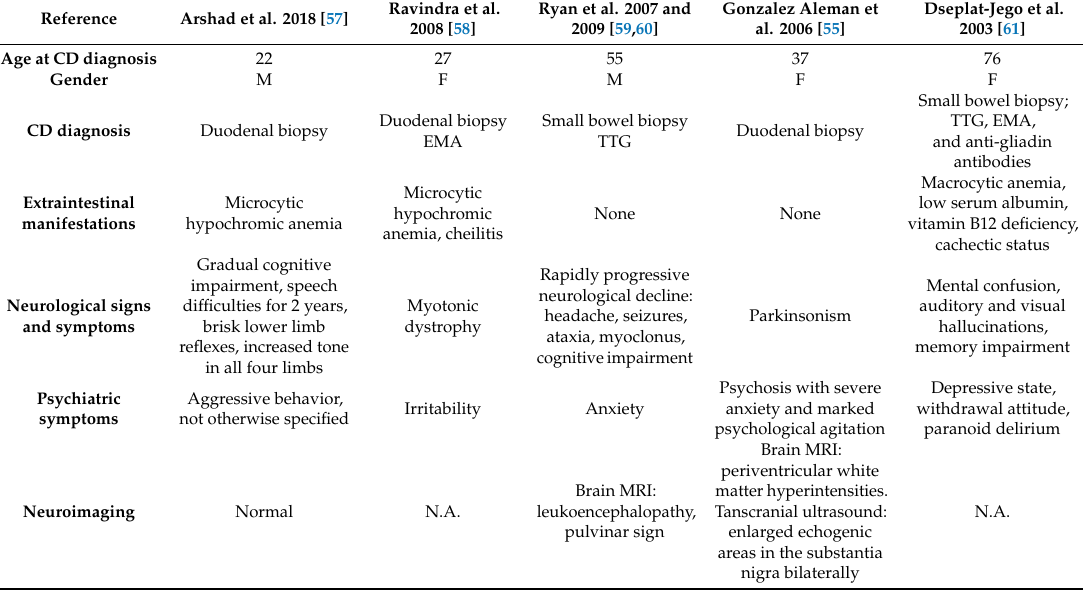
Table 1. Case reports about adult (age > 18) patients, with biopsy-proven celiac disease (CD), with neurological and psychiatric